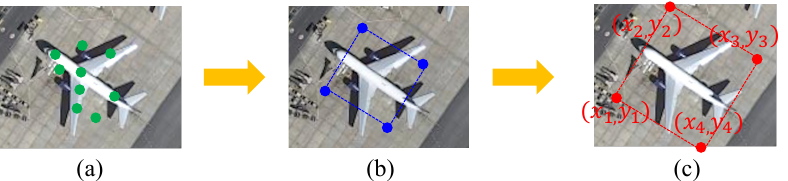
Figure 5. Illustration of the detection process of the Point RCNN framework. ( a ) denotes the predicted representative points with the PointRPN module. ( b ) denotes the conversion from the representative points to the rotated proposals. ( c ) denotes the refinement process of the corner points with the PointReg